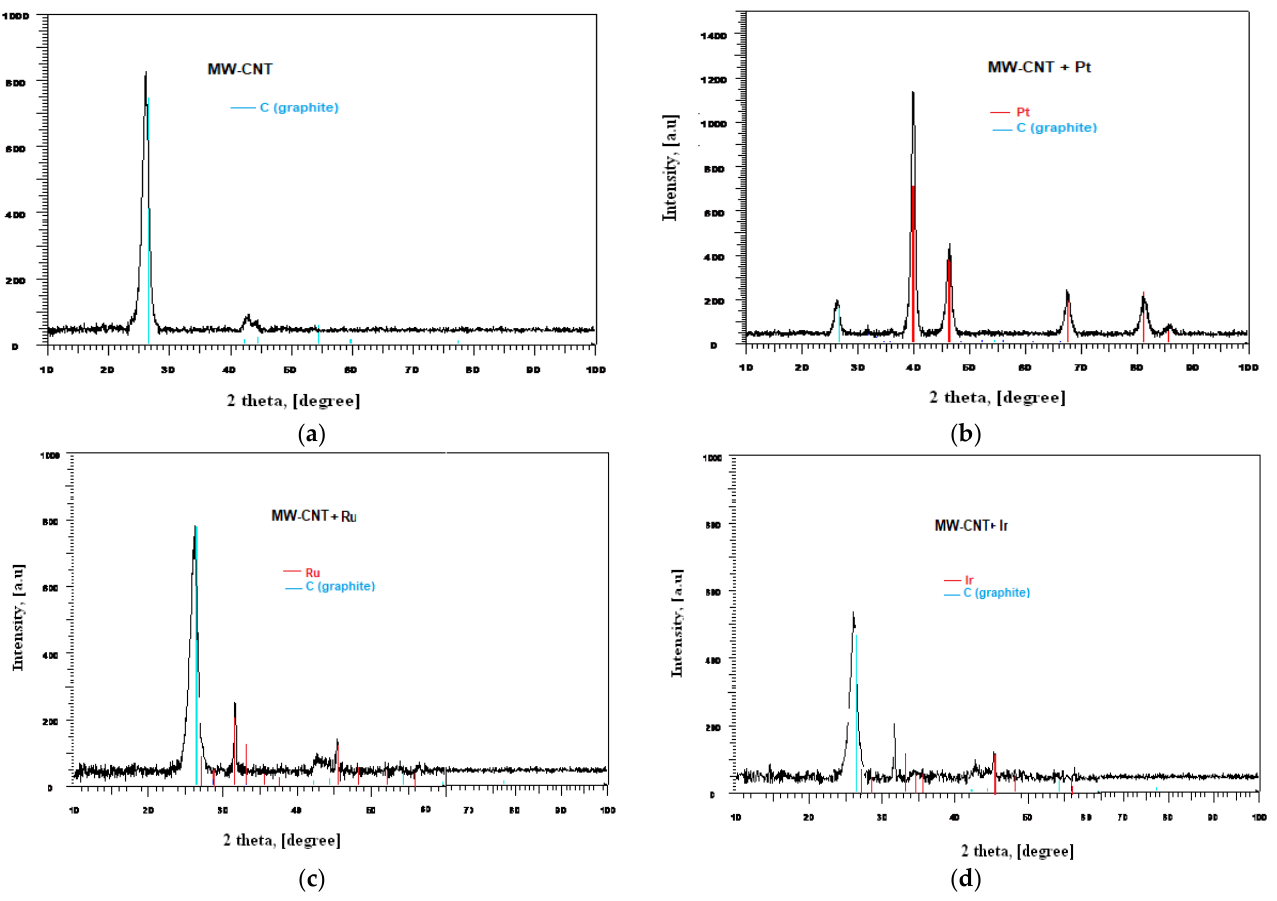
Figure 1. X-Ray plots for ( a ) MW-CNTs, ( b ) MW-CNTs + Pt, ( c ) MW-CNTs + Ru, ( d ) MW-CNTs + Ir.